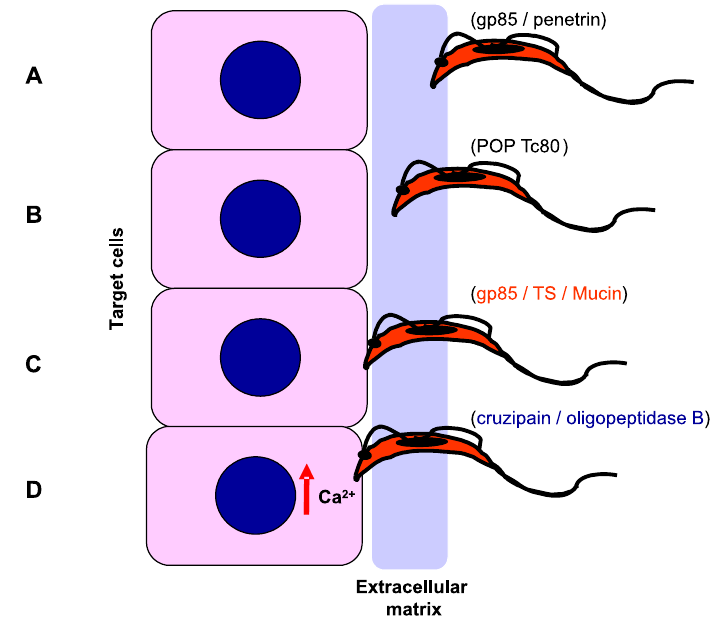
Fig. 7 – Model of molecular interaction of T. cruzi bloodstream trypomastigotes with target cells. The extracellular matrix may constitute in many instances a barrier trypomastigotes have to over- come to reach the host cells. A) TCT attach to the extracellular matrix using molecules such as gp85 and penetrin, which have affinity for laminin, fibronectin, collagen, heparin. B) To translocate through the matrix, the parasite may use POP Tc80, which has collagen/fibronectin hydrolyzing activity. C) Adhesion to and invasion of target cells can be mediated by gp85, TS and/or mucins. D) Binding of TCT to target cells induce the activation of oligopeptidase B that generates a Ca 2+ agonist, as well as the secretion of cruzipain that indirectly triggers Ca 2+ response in host